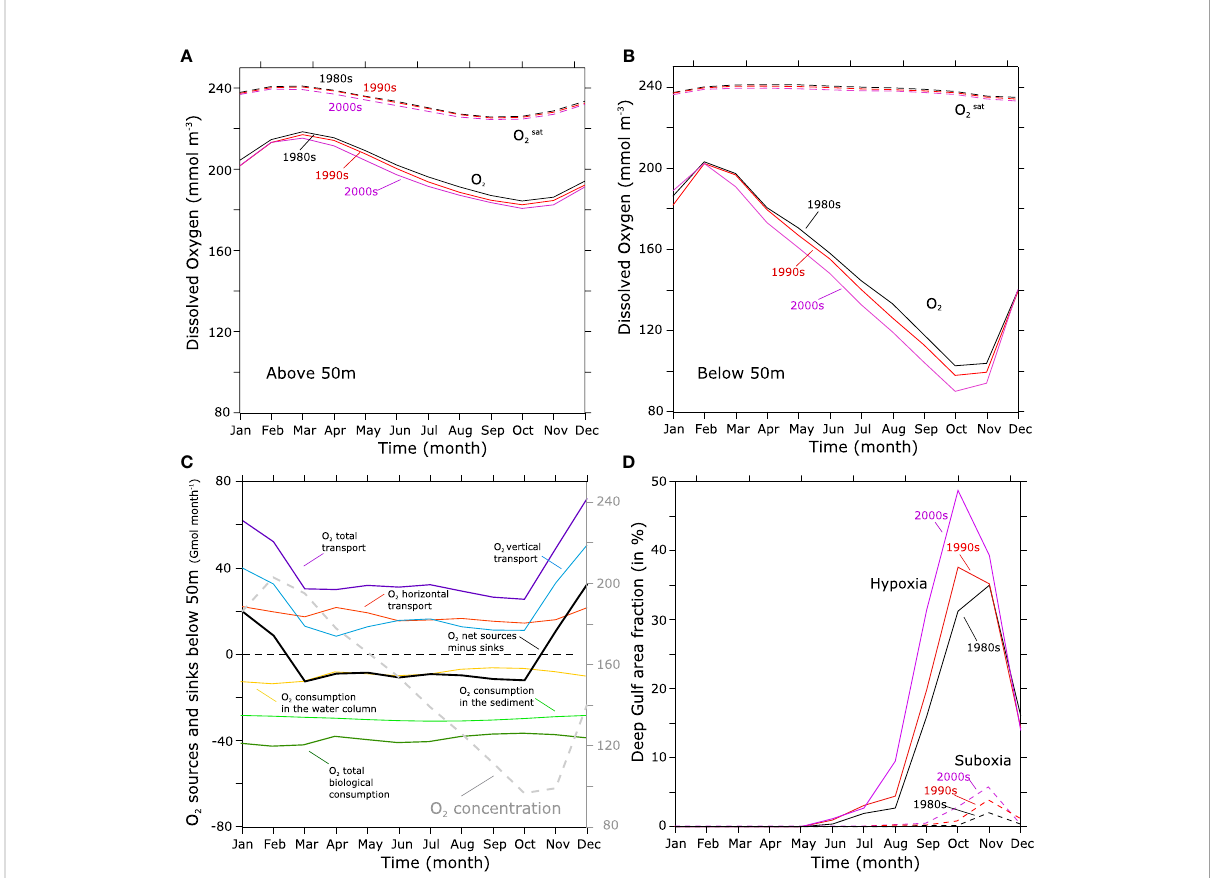
FIGURE 3 Seasonal variation in O 2 and bottom hypoxia. (A, B) Average seasonal cycle in O 2 (solid) and O sat 2 (purple) above 50m (A) and below 50m (B) . (C) Seasonal variation in annual mean O 2 concentrations (dashed gray line) and in physical and biological sources and sinks (solid lines) in the Gulf below 50 m. (D) hypoxic (O 2 < 60 mmol m -3 ) (solid) and suboxic (O 2 < 4 mmol m -3 ) (dashed) area fraction (in %) in the deep Gulf (bathymetry deeper than 50 m) in the 80s (black), 90s (red) and 2000s